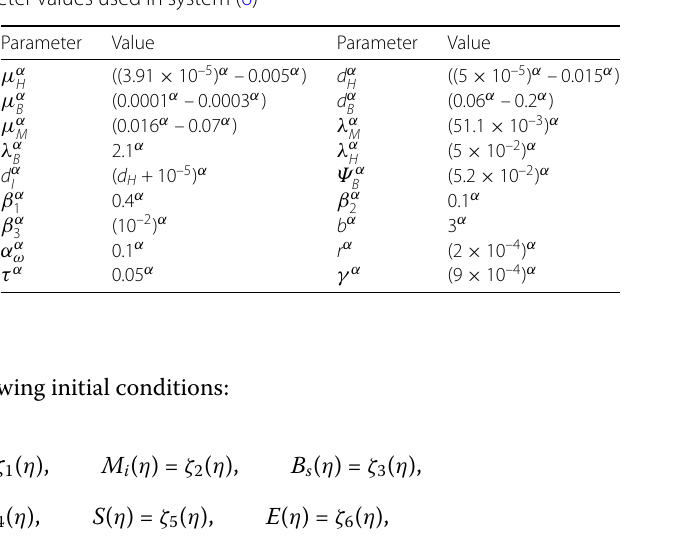
Table 3 Parameter values used in system